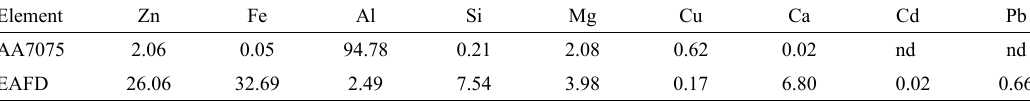
Table 1. Chemical analysis of the main elements present in the EAFD and AA7075. Element